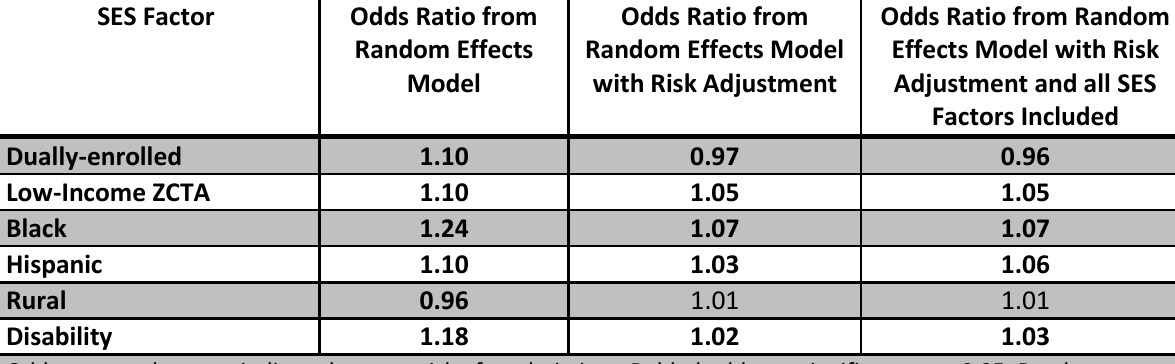
Table 12.4: Within-Facility Relationships between Social Risk Factors and Readmission, 2014 SES